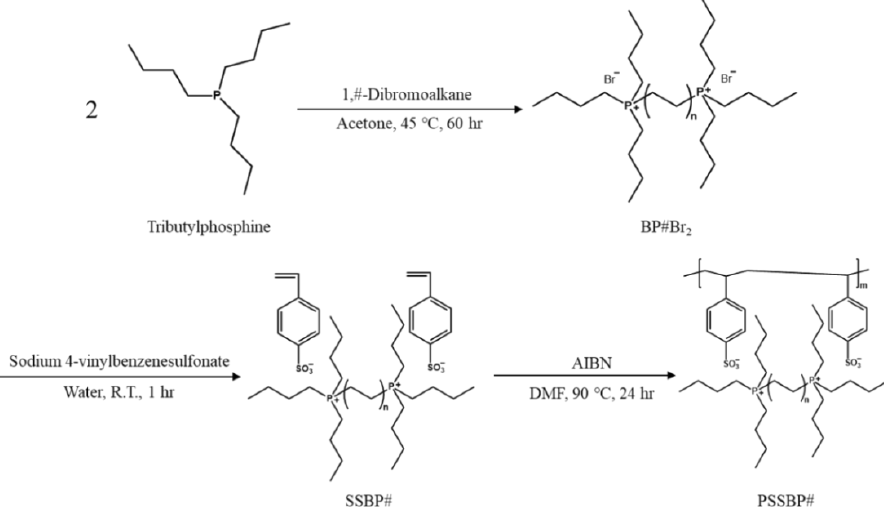
Figure 2. Preparative and synthetic scheme for dicationic phosphonium bromide (BP#Br 2 ), where # is number of carbon atoms in centered bridge structure of dicationic phosphonium moiety, dicationic phosphonium 4-vinylbenzeneesulfonate (SSBP#), and poly(dicationic phosphonium 4-vinylbenzenesulfonate) (PSSBP#).